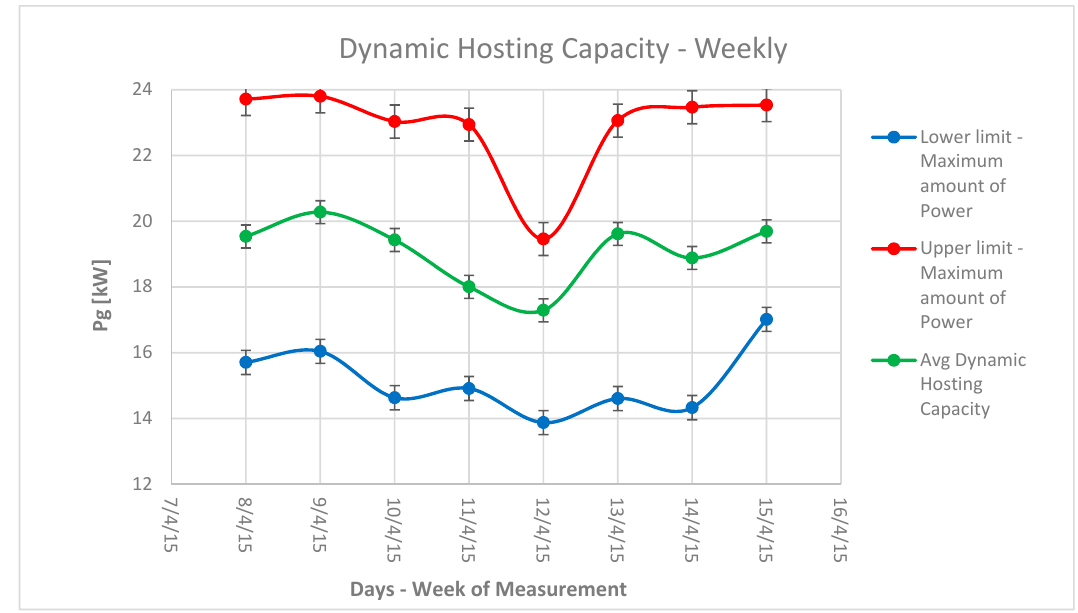
Figure 15. The Weekly Dynamic Hosting Capacity Profile.